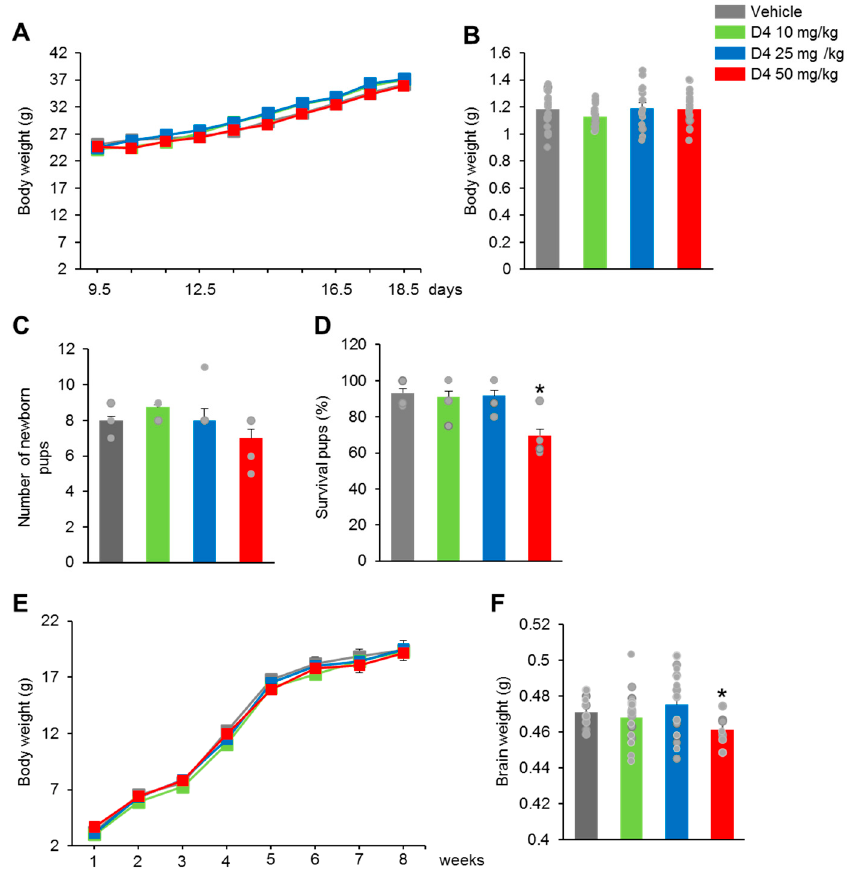
Figure 2. Prenatal D4 treatment reduced the survival of pups. ( A ) D4 treatment showed no changed in the body weight of the dams ( n = 5–6 per group) (E19.5, F 3,18 = 0.9215, p = 0.4543). ( B ) The body weight on PND1 ( n = 20 per group) (F 3,74 = 1.049, p = 0.3763) and ( C ) the number of newborn pups ( n = 5–6 per group) (F 3,19 = 0.7416, p = 0.5427) were shown. ( D ) The survival of pups was significantly decreased in the D4 50 mg/kg group ( n = 40 per group) (F 3,19 = 4.327, p = 0.0276). ( E ) There was no change in the body weight of the pups after birth ( n = 40 per group) (PND28, F 3,94 = 2.534, p = 0.0205; PND56, F 3,94 = 1.223, p = 0.3072). ( F ) However, the brain weight was decreased in the D4 50 mg/kg group compared to vehicle group ( n = 10 per group) (F 3,38 = 3.568, p = 0.0237). Data represent mean ± SEM. Statistical significance was determined by one − way ANOVA with Bonferroni correction. * p < 0.05 vs. vehicle. Treatments: corn oil; vehicle, D4; 10 mg/kg/day, D4; 25 mg/kg, D4; 50 mg/kg.